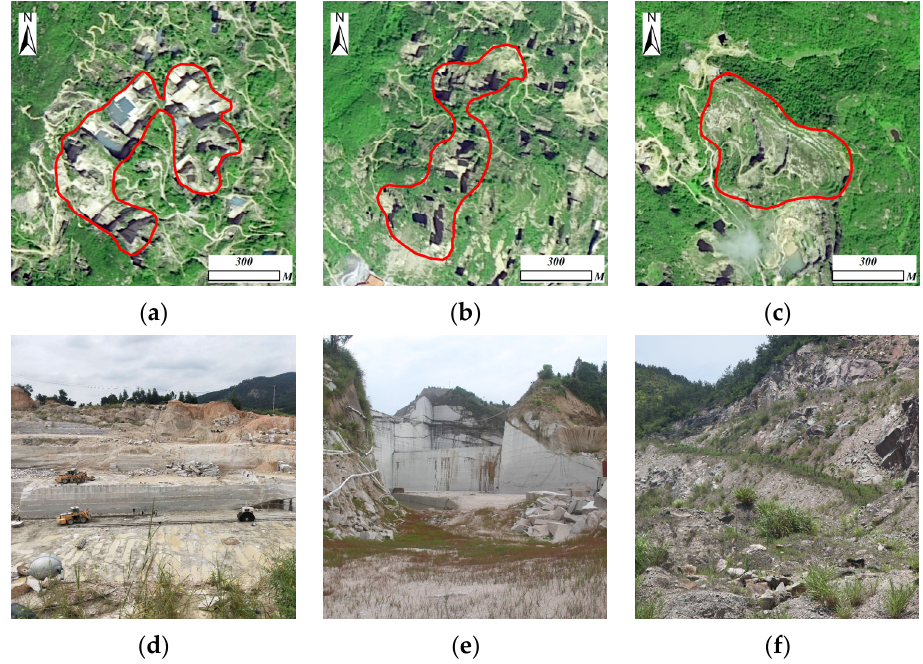
Figure 2. Satellite imagery (from GaoFen-2 dataset) and corresponding field photo of 3 typical ex- ploiting states’ mines in the study area: ( a , d ): Using mine; ( b , e ): Discarded mine; ( c , f ): Restored mine.